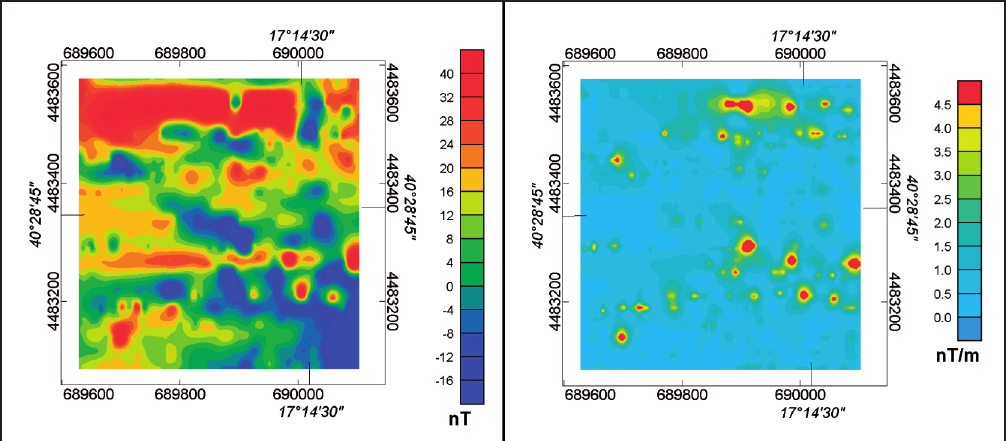
Fig. 6. Left panel: magnetic anomaly map in the restricted boxed area. Right panel: example of a 3D magnetic analytic signal evaluated by computing the numerical derivative of the magnetic